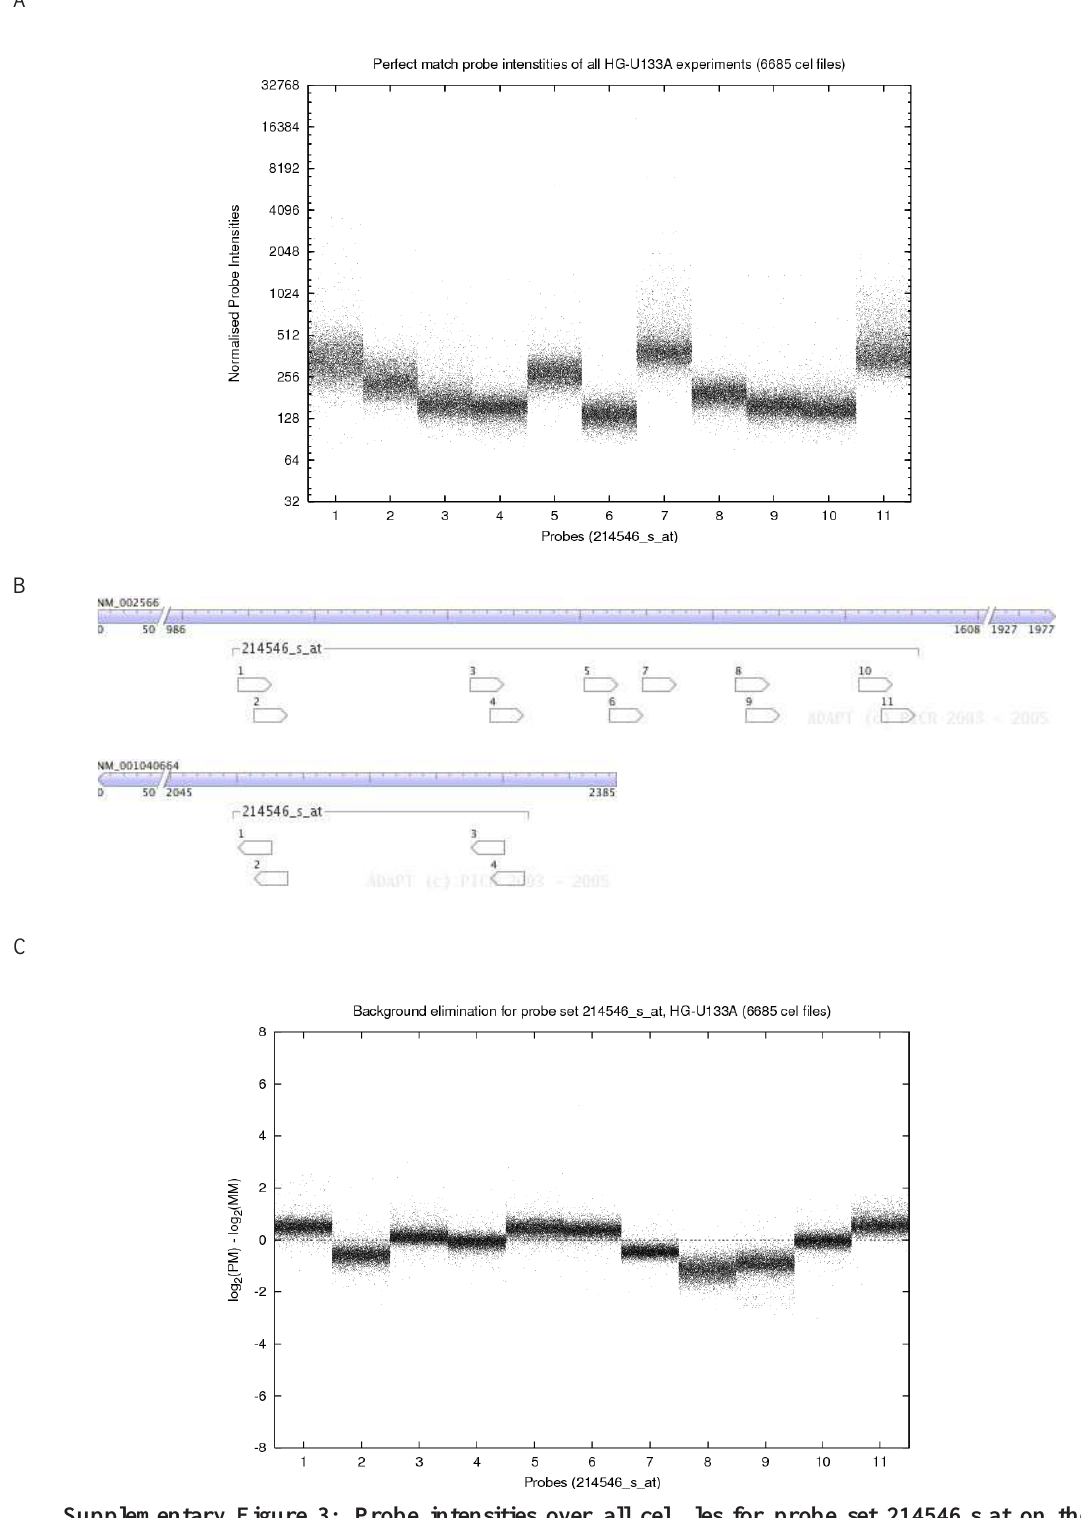
Supplementary Figure 3: Probe intensities over all cel files for probe set 214546 s at on the HG U133A array (A) Perfect match intensities (log scale) (B) ADAPT probe positions on the tran- scripts (C) Background elimination (log 2 (PM) - log 2